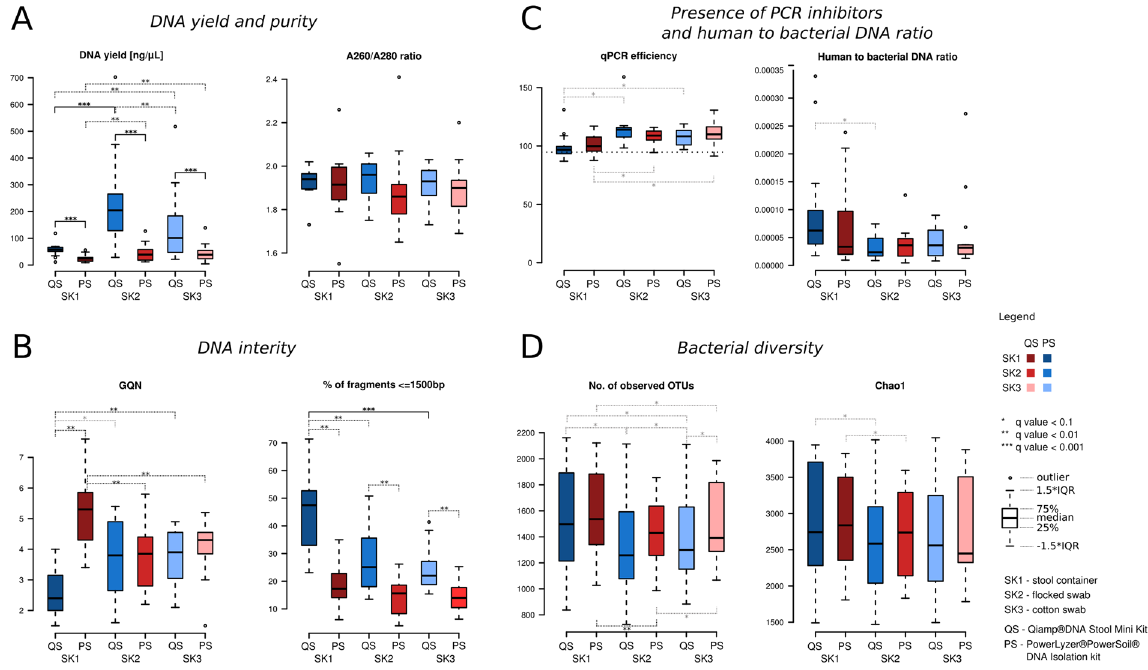
Figure 1. Comparison of sample DNA quality and diversity using different sampling and isolation kits. ( A ) DNA yield and purity comparison. d the samples were five times diluted prior the DNA extraction (see Methods); ( B ) DNA integrity comparison; ( C ) Presence of PCR inhibitors and human to bacterial DNA ratio comparison. Horizontal dotted line represents median efficiency value of the positive control; ( D ) Bacterial diversity